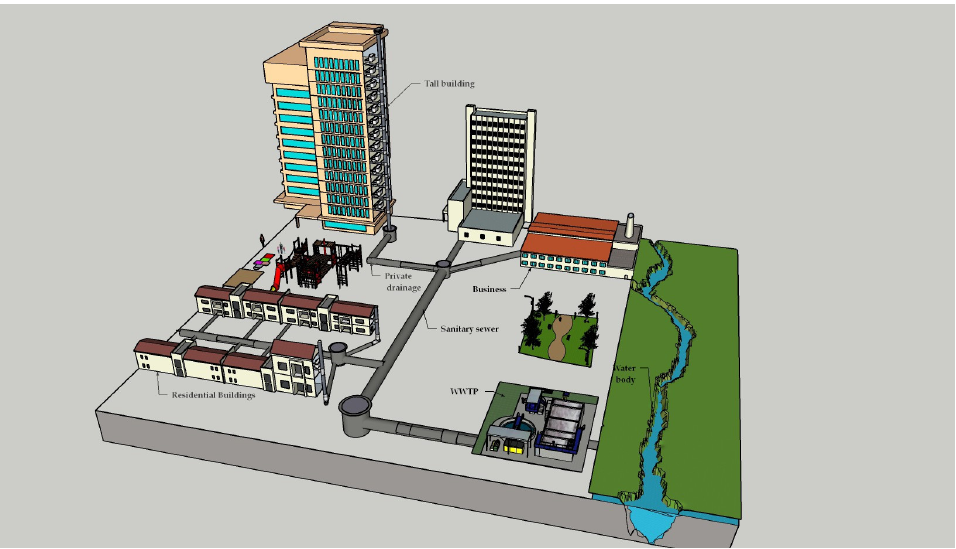
Figure 1. Connection of waste pipes to main drainage.